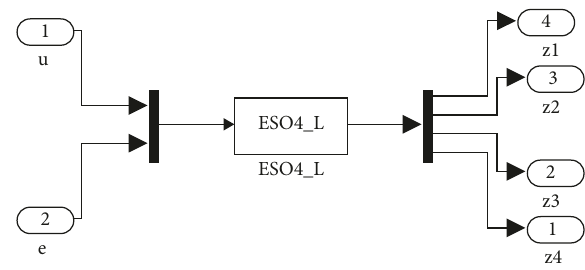
Figure 14: Modular composition of the ESO subsystem.